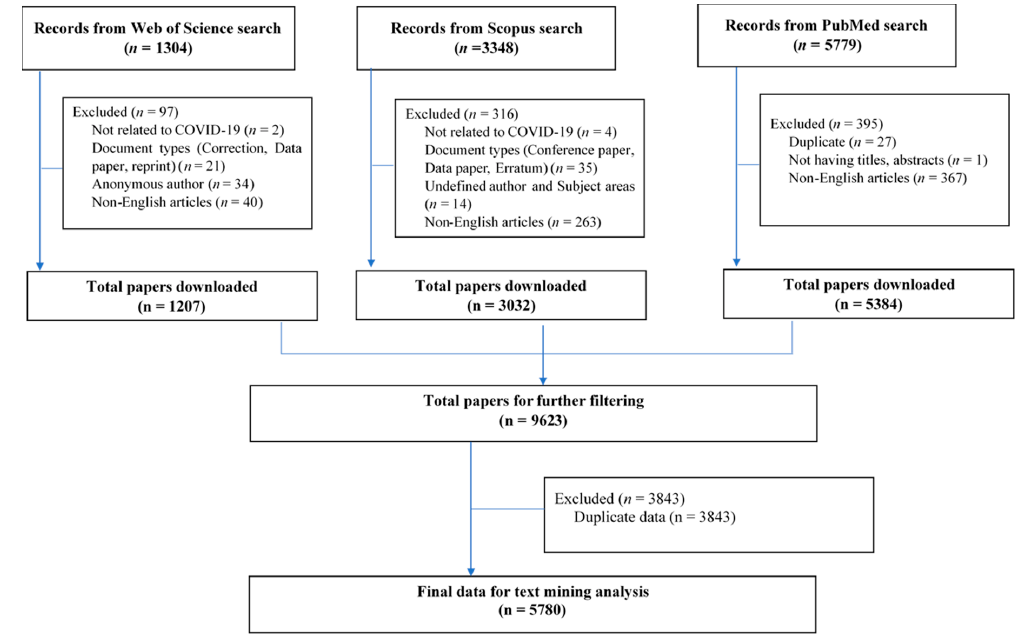
Figure 1. Selection process.